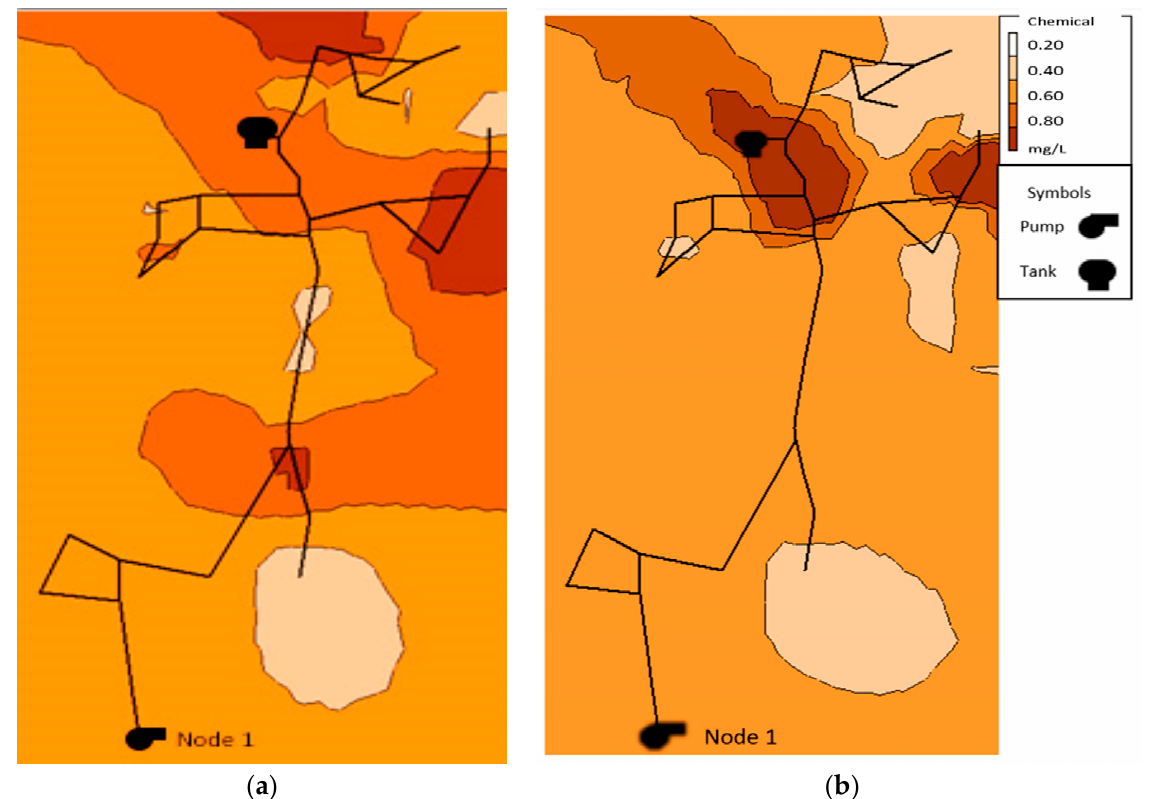
Figure 8. FRC distribution at hour 72. ( a ) Generated by the GA solution. ( b ) Generated by the PSO solution. Both results obtained a full coverage with at least 0.2 mg/L. It was observed that PSO